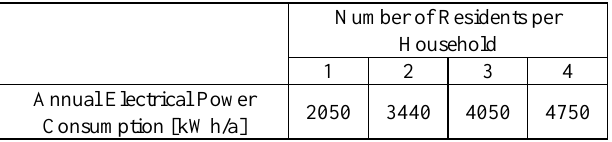
Table 4. Annual electric power consumption of a household in Berlin w.r.t the number of residents [Vattenfall,